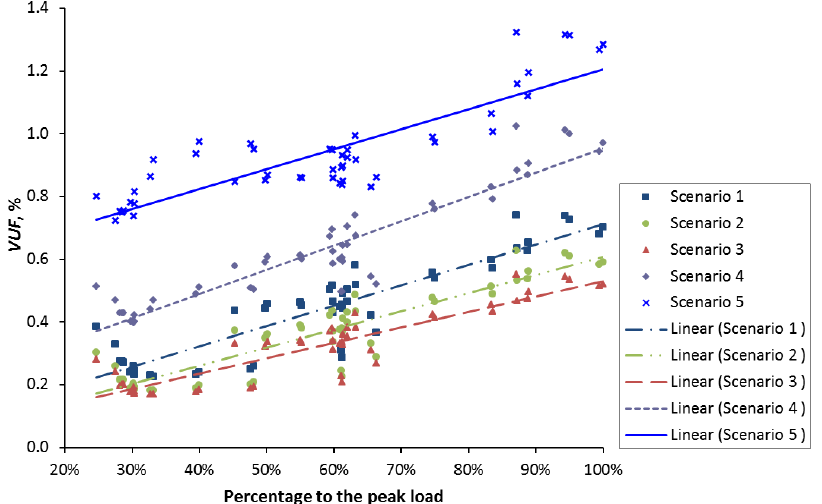
Figure 6. Correlation between percentage of peak load and 𝑉𝑈𝐹 s at the LV busbar.